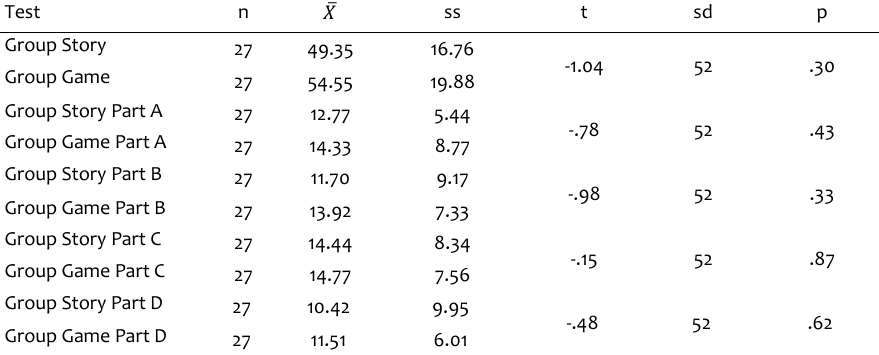
Table 8. The results of the Independent Samples t-Test regarding the comparison of the pre-test-post-test difference scores of the Group Story and the Group